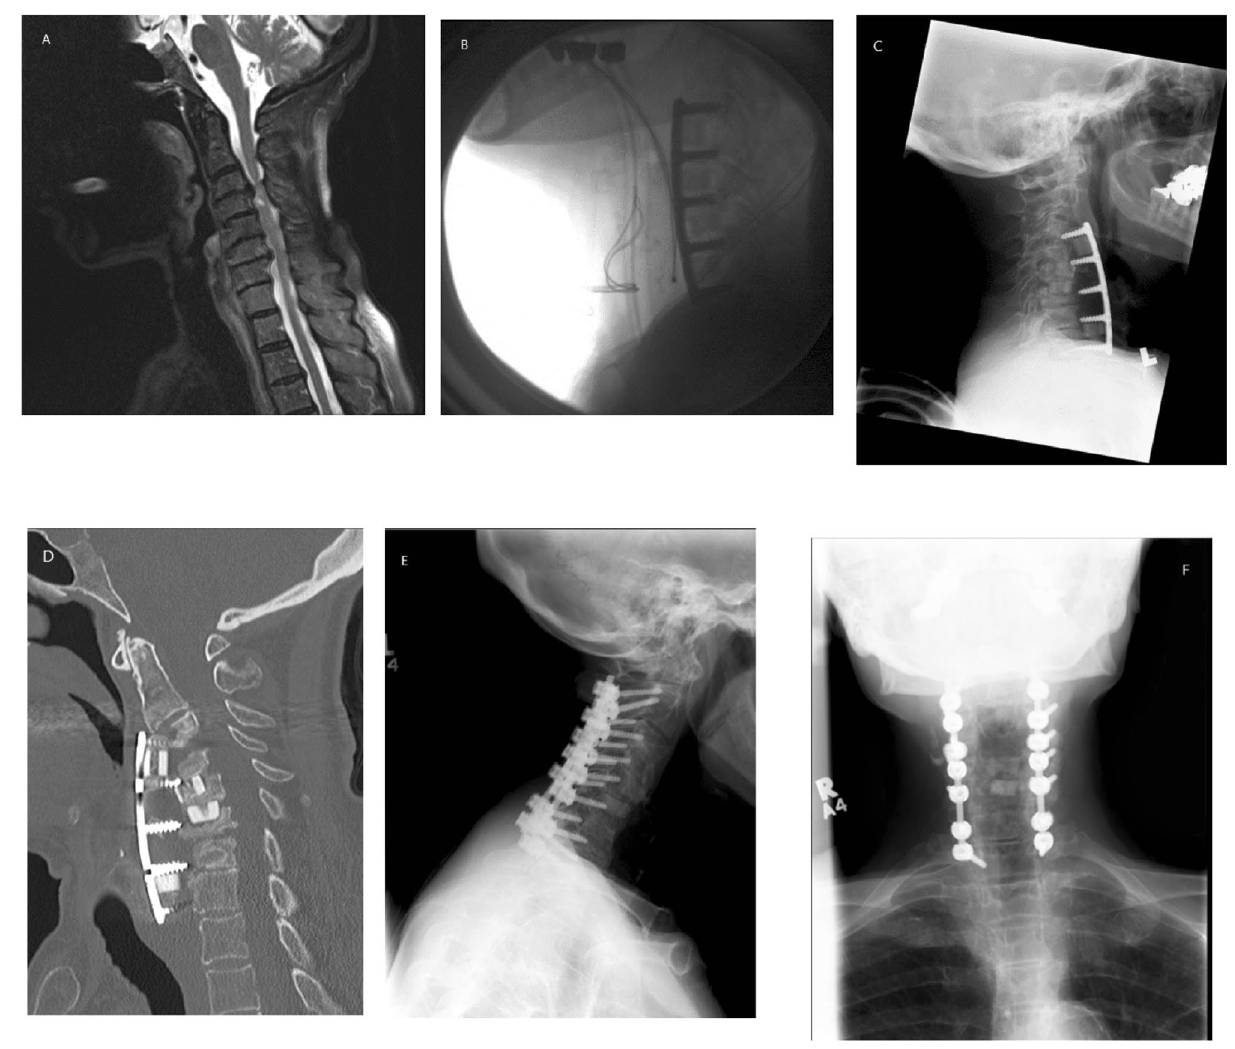
Figure 3. A 77-year-old female who presented with severe progressive myelopathy. A MRI scan of the cervical spine showed significant multilevel stenosis and cord compression ( A ). The patient underwent a four-level ACDF at the levels C3–C7 with good result ( B ). She was seen on a routine 8-week postoperative visit. The patient had no specific complaints and no swallowing dysfunction. She was improving neurologically. Lateral X-ray films showed complete dislodgement of the anterior hardware at all levels with the new onset of kyphosis ( C , D ). The patient underwent urgent revision with removal of previous anterior fixation hardware, repeat bone grafting C3–C7 and posterior C2–C5 decompression and C2–Th1 instrumented fusion ( E , F ). The ultimate outcome was excellent with significant resolution of